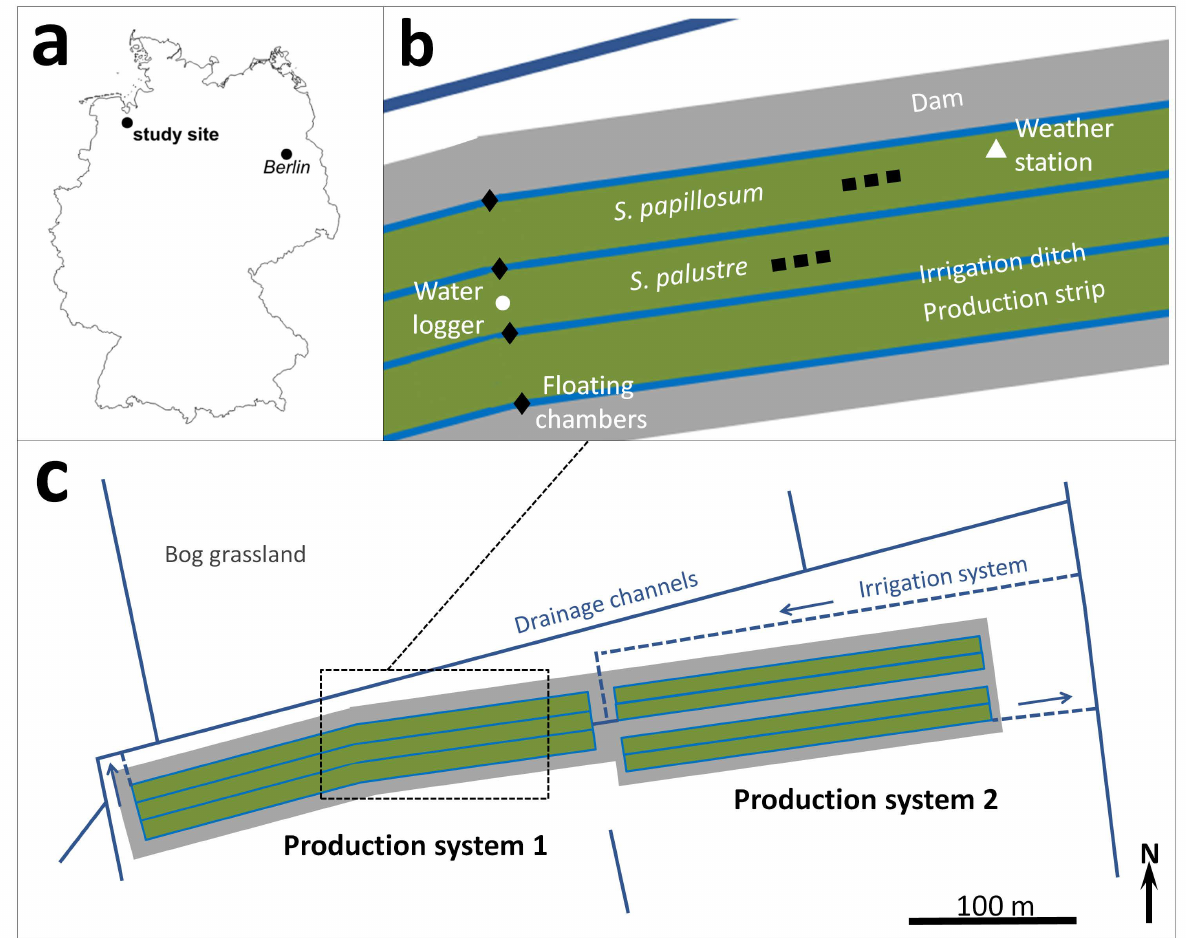
Figure 1 The experimental Sphagnum farming field: (a) location in Germany in the municipality Rastede; (b) position of the weather station (white triangle), water logger (white circle), sampling plots (black squares) and floating chambers (black diamonds); (c) composition and arrangement of the two production systems.